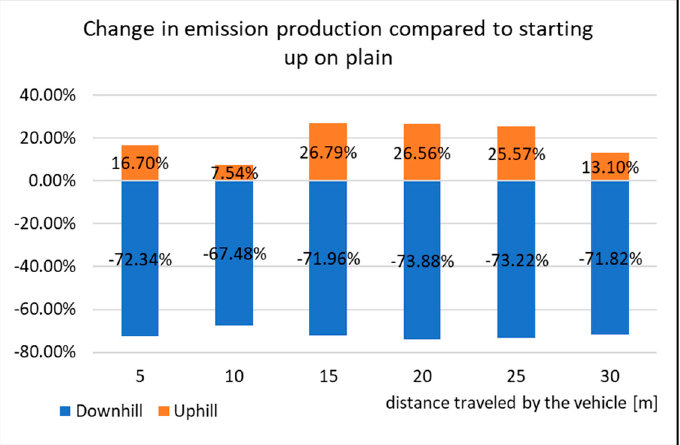
Figure 17. Change in emission production compared to starting up on a plain.